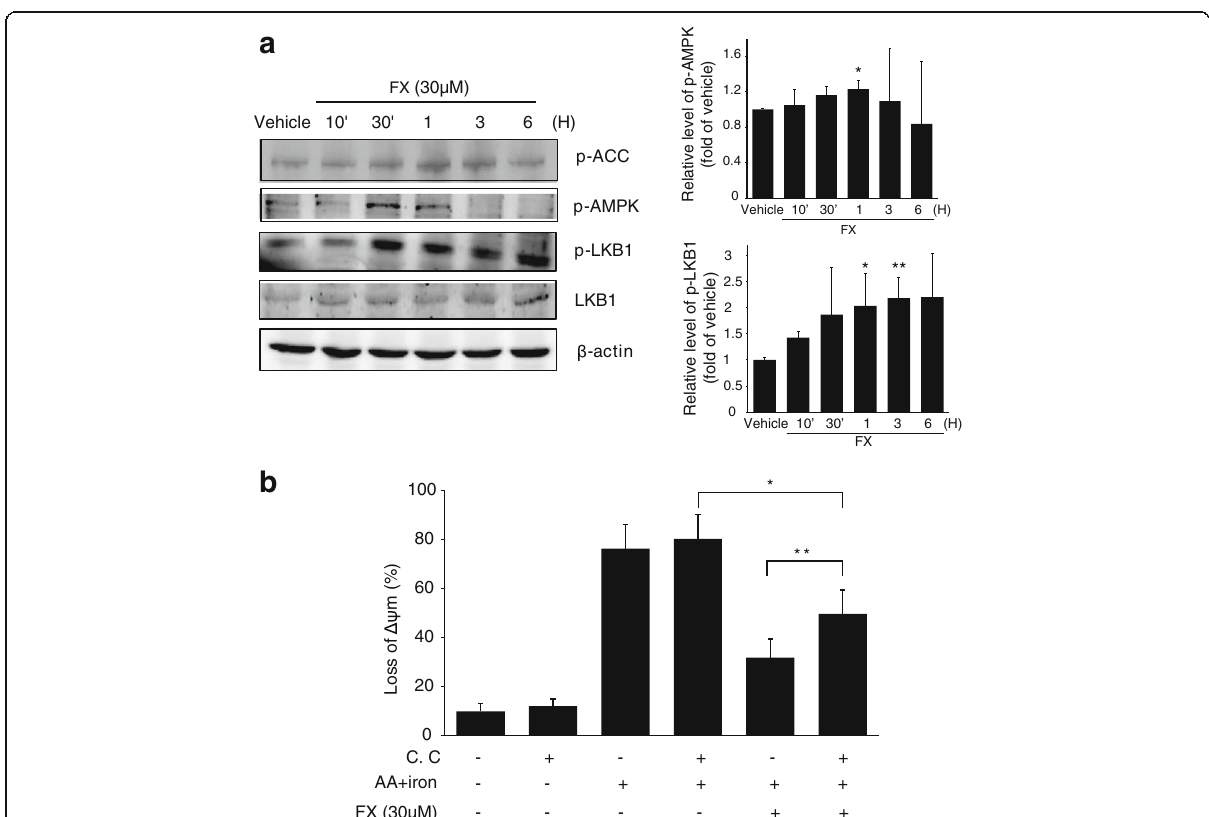
Fig. 3 FX-induced the activation of AMPK alleviates cell damage by oxidative stress. ( a ) FX induces phosphorylation of the proteins associated with AMPK pathway, ACC, LKB1 and AMPK. Western blot analyses were performed with the lysates of cells that had been treated with 30 μ M FX for the indicated time period. β -actin served as a loading control. Protein levels were presented as relative band intensities to control (vehicle treated) group. Results represent the mean±S.D. for three separate experiments. * p <0.05; ** p <0.01; *** p <0.001. ( b ) The effect of FX to restore ΔΨ m was revered by C.C. Following treatment with 10 μ M C.C for 1 h, cells were incubated with FX and/or AA + iron, and ΔΨ m was evaluated with Rh123 stain by FACS. Data represent the mean±S.D. for four replicates. * p <0.05; ** p